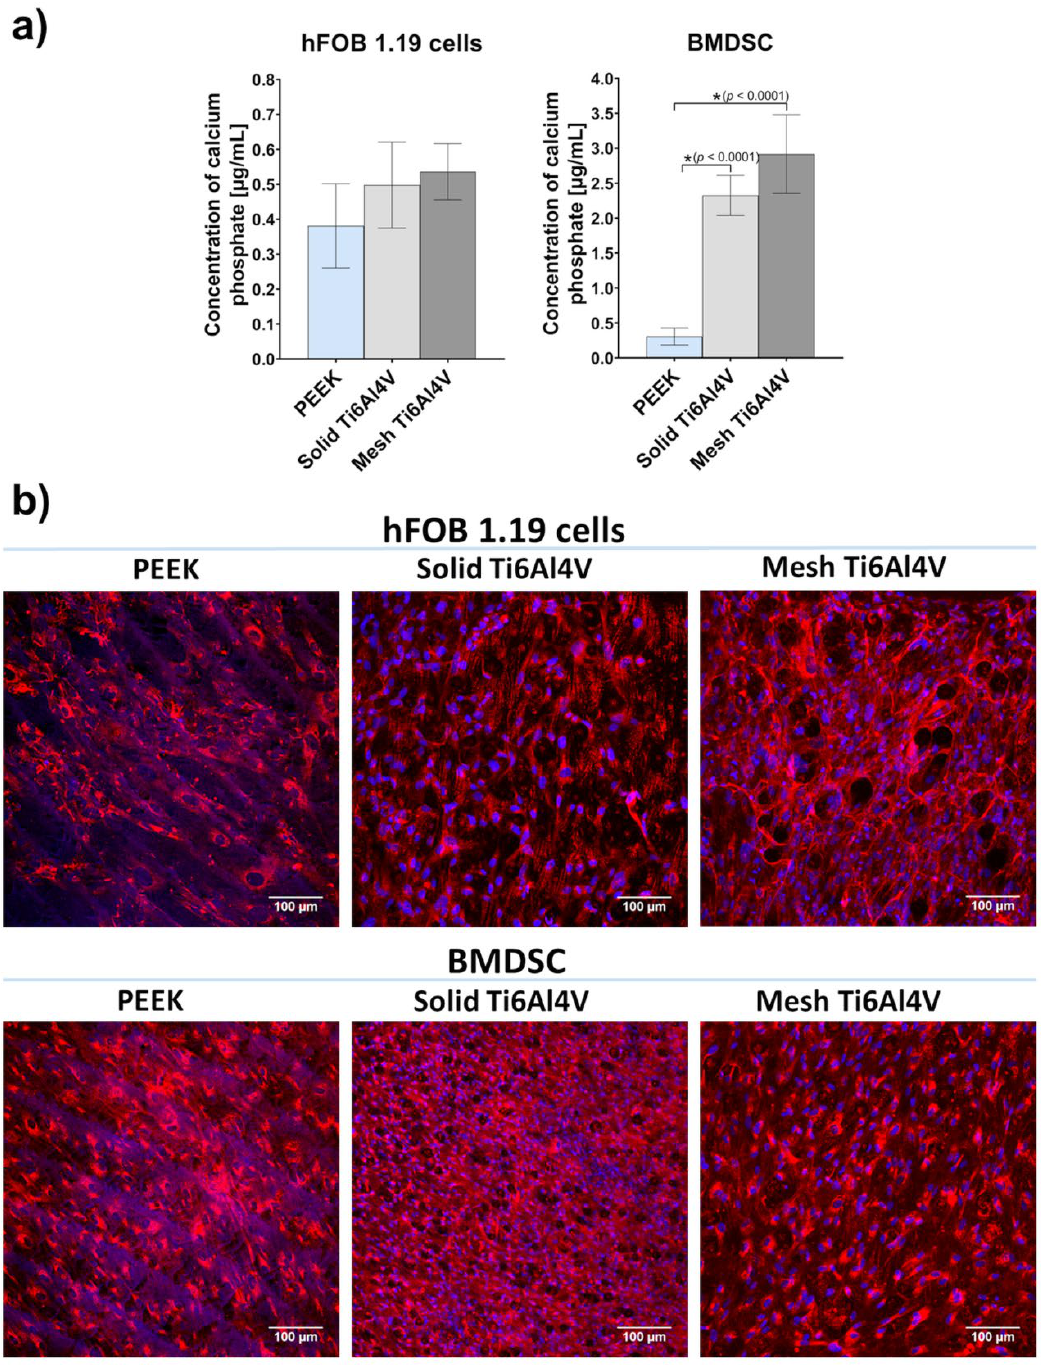
Figure 9. ECM mineralization in response to tested samples: ( a ) quantitative mineral determination based on ARS staining (* indicates statistically significant results according to One-way ANOVA followed by Tukey’s multiple comparison test); ( b ) immunofluorescent staining of Col I fibers acting as a framework for mineral deposition (red fluorescence—Col I, blue fluorescence—nuclei; magnification 200 × , scale bar = 100 µ